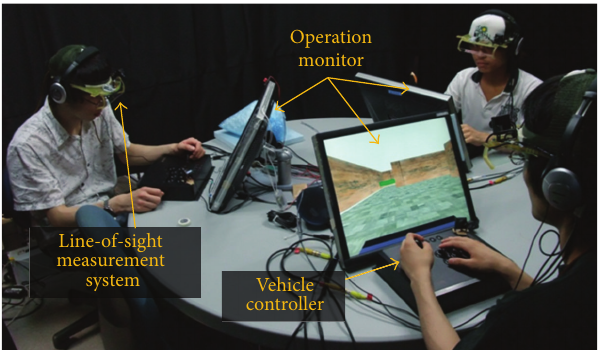
Figure 1: Experimental scene of cooperative-carrying task.